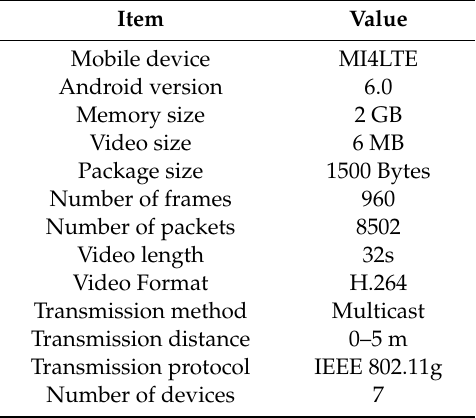
Table 1. Experiment parameters.